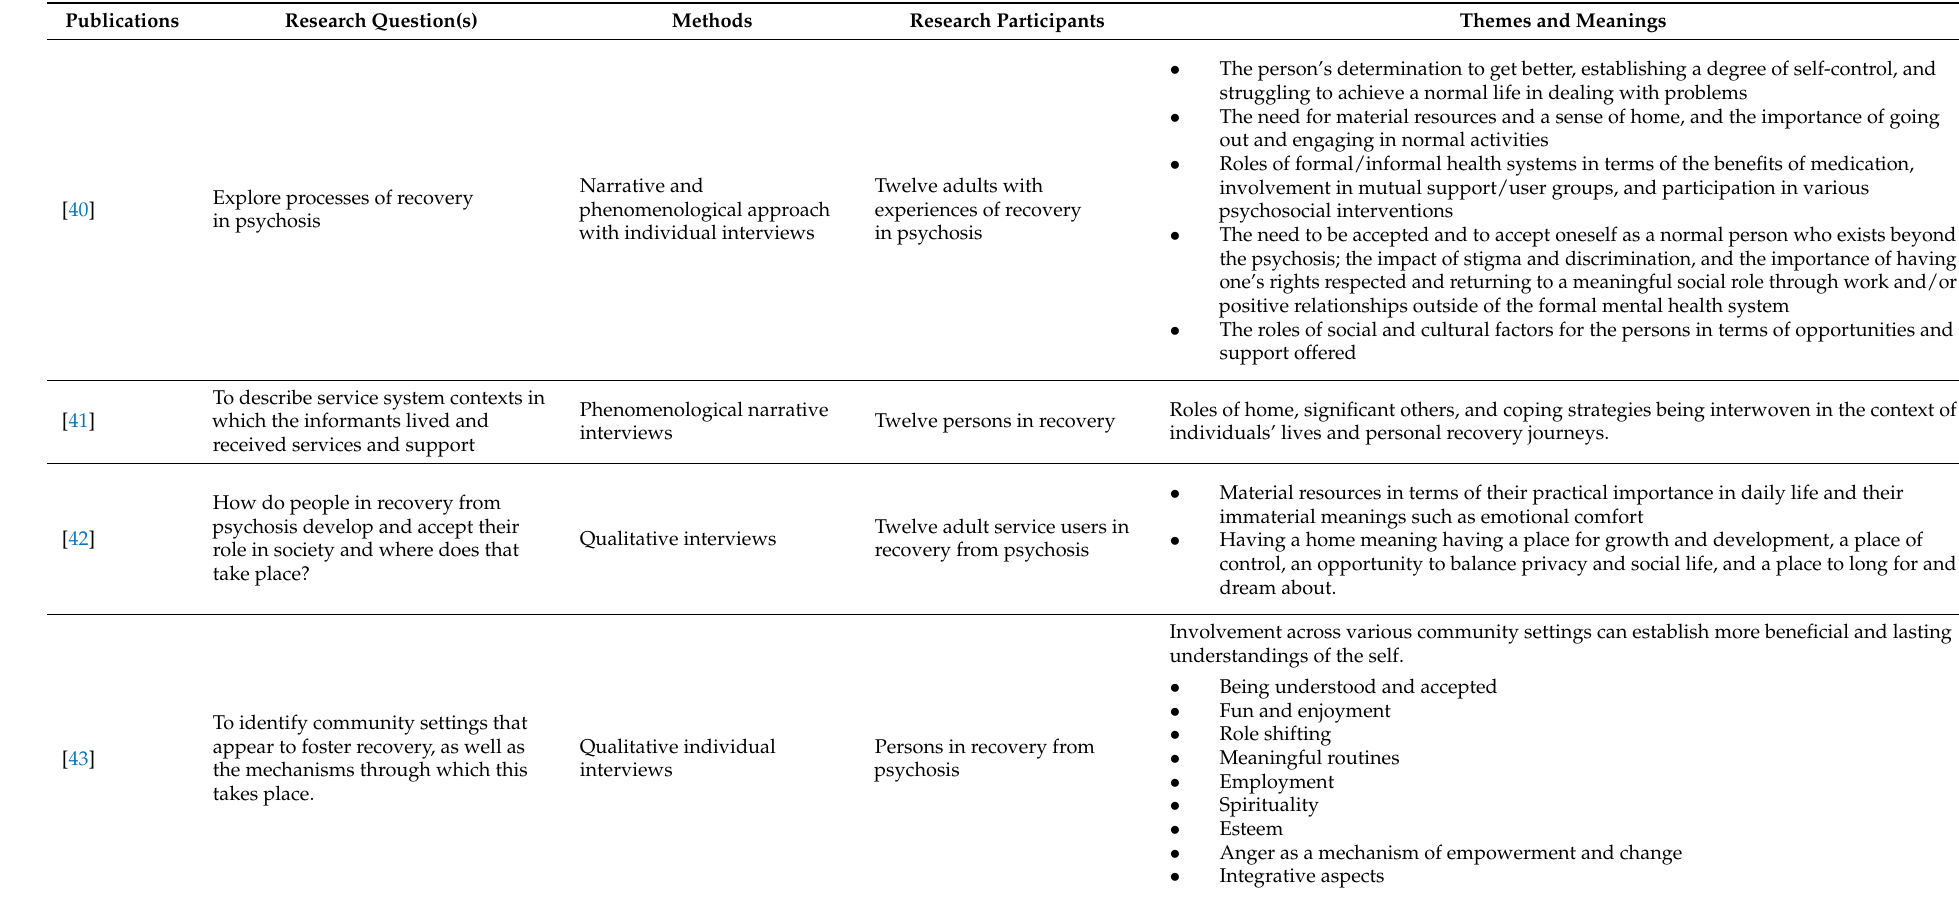
Table 1. Included papers in the